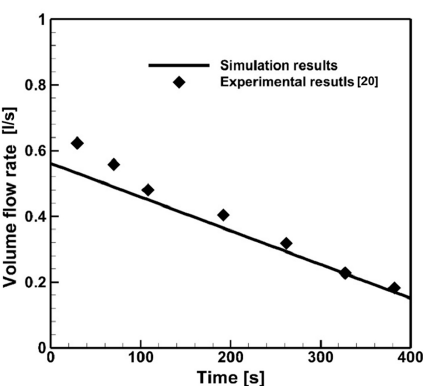
Figure 2. The computational domain that replaces the experimental facility [20].